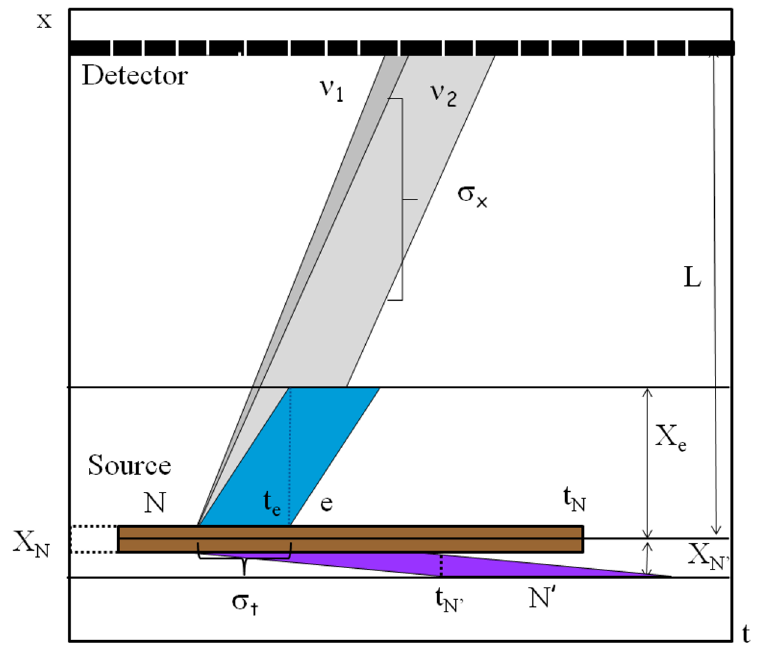
Figure 1 . Schematic representation (space-time localization diagram) for neutrino production, propagation and detection in reactor experiments. Wave packets of the decaying nucleus N , daugh- ter nucleus N 0 , electron and mass-eigenstate components of the emitted neutrino are represented by brown, violet, blue and gray bands, respectively. The slopes of the bands are determined by the group velocities of the particles. Black rectangles at x = L show localization of the neutrino detection process. For simplicity, the WPs of only two neutrino mass eigenstates are